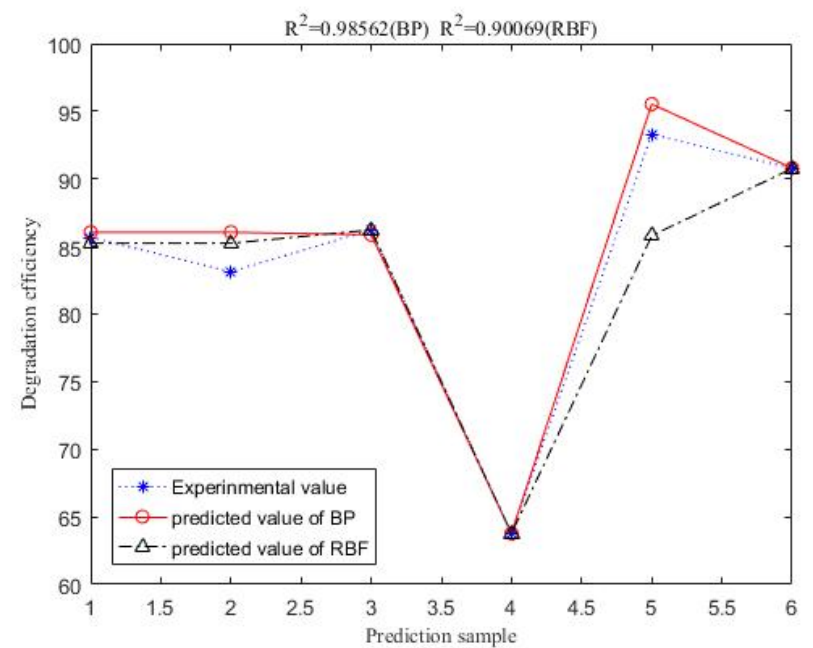
Figure 24. Comparison of the predicted value of the radial basis function and the predicted value of BP with the experimental